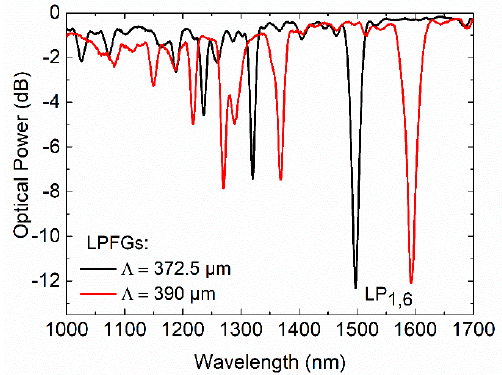
Figure 3. Spectra of fs-laser direct written LPFGs in single mode fiber (SMF-28e).